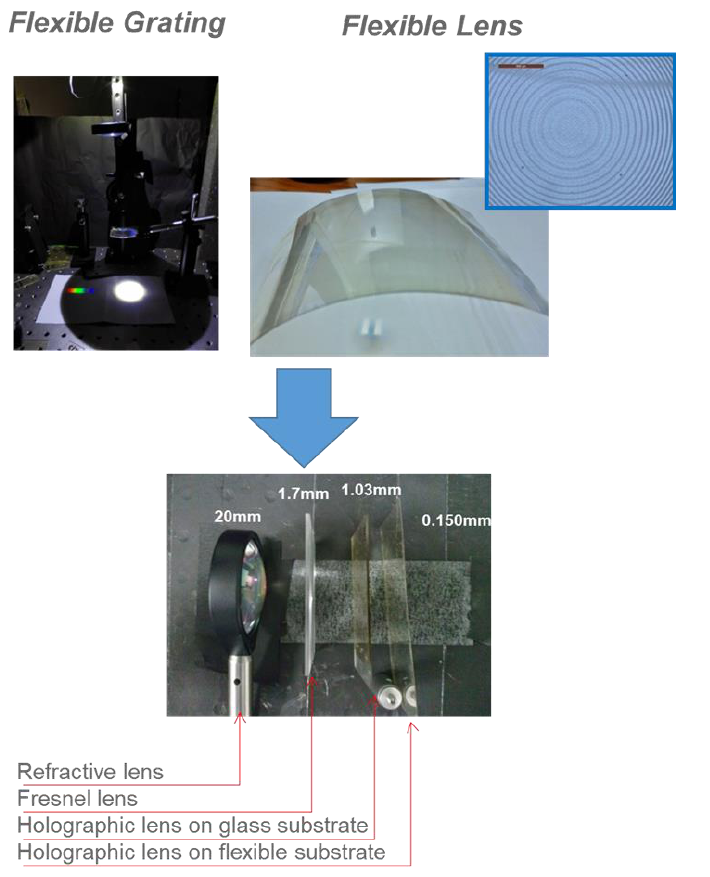
Figure 15. V-HOEs recorded on a flexible support.